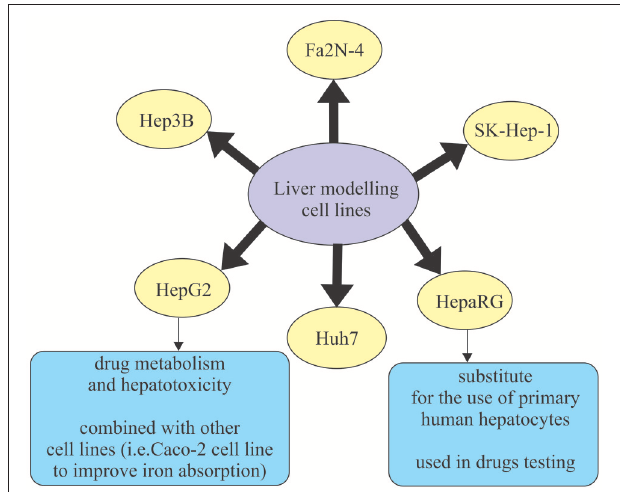
FIGURE 2 | List of commonly used liver cell